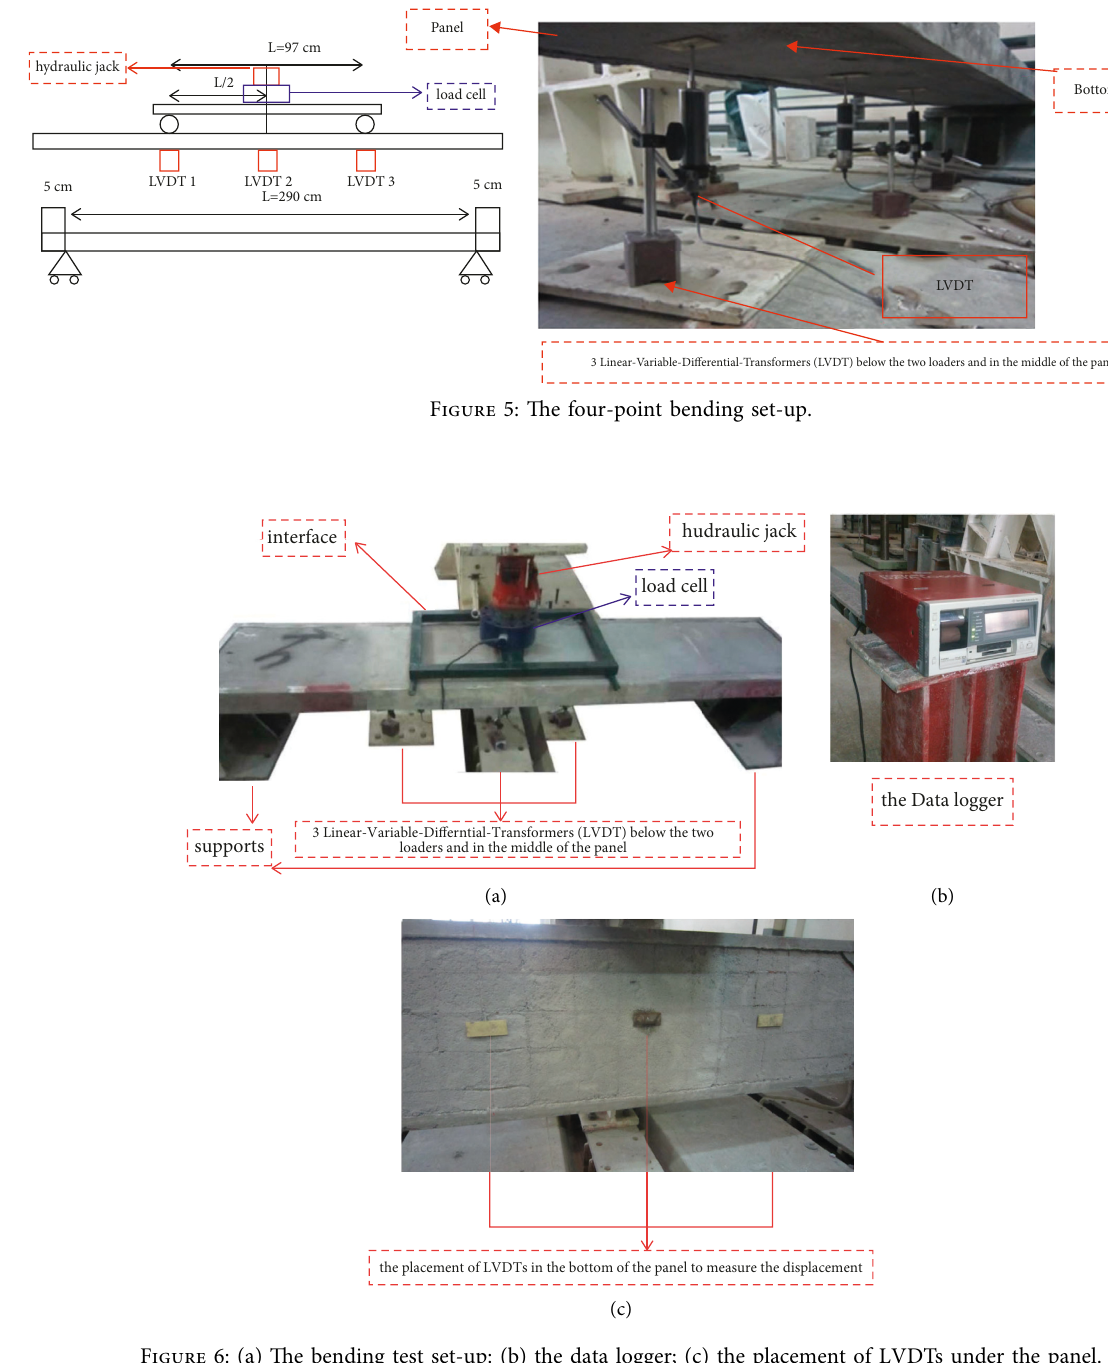
Figure 6: (a) The bending test set-up: (b) the data logger; (c) the placement of LVDTs under the panel.